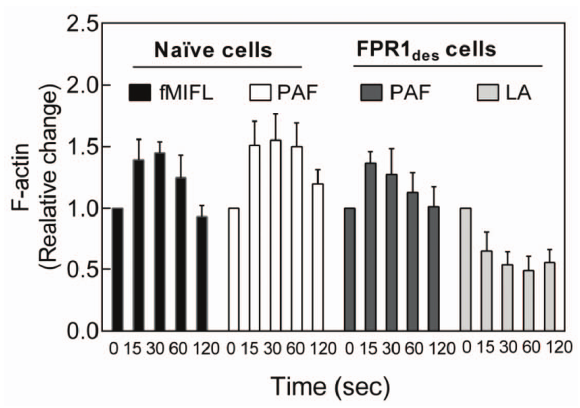
Figure 7. PAF induces actin polymerization in both naı¨ve and FPR1 des neutrophils. Human neutrophils (naı¨ve or FPR1 des ) were activated with a receptor agonist or latrunculin A and the change in polymerized actin was determined att different time points (15 to 120 sec) after activation. Naı¨ve neutrophils were activated by PAF